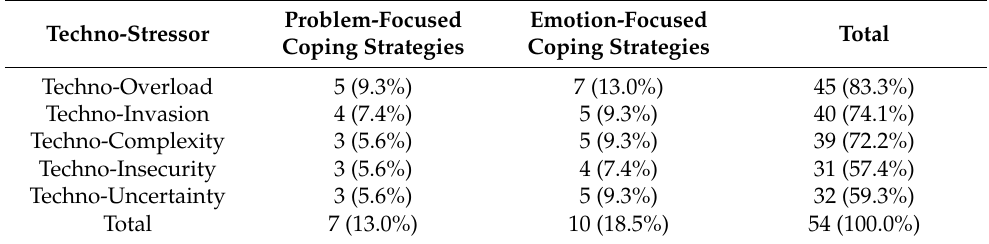
Table 5. Frequencies of techno-stressors and coping strategies in quantitative studies ( n = 54) 1 . Techno-Stressor